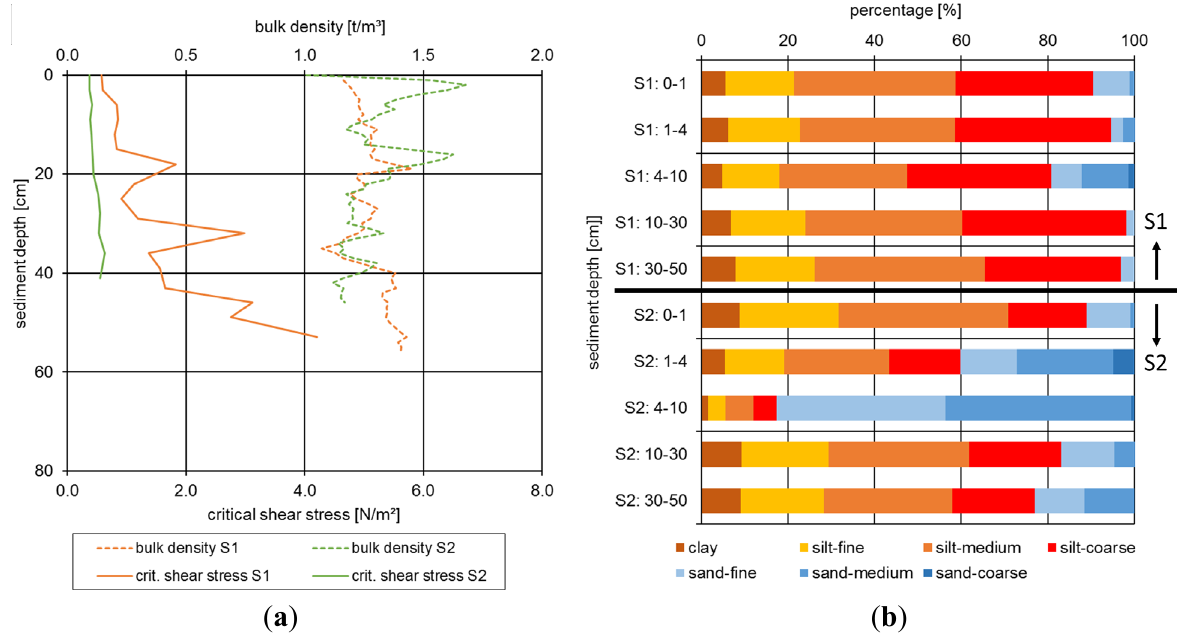
Figure 5. ( a ) Vertical profiles of sediment bulk density and critical shear stress based on laboratory measurements for two sampling sites in the catchment of River Saale (S1 and S2); ( b ) particle size distributions at distinct layers of the two sampling sites in the catchment of River Saale (S1 and